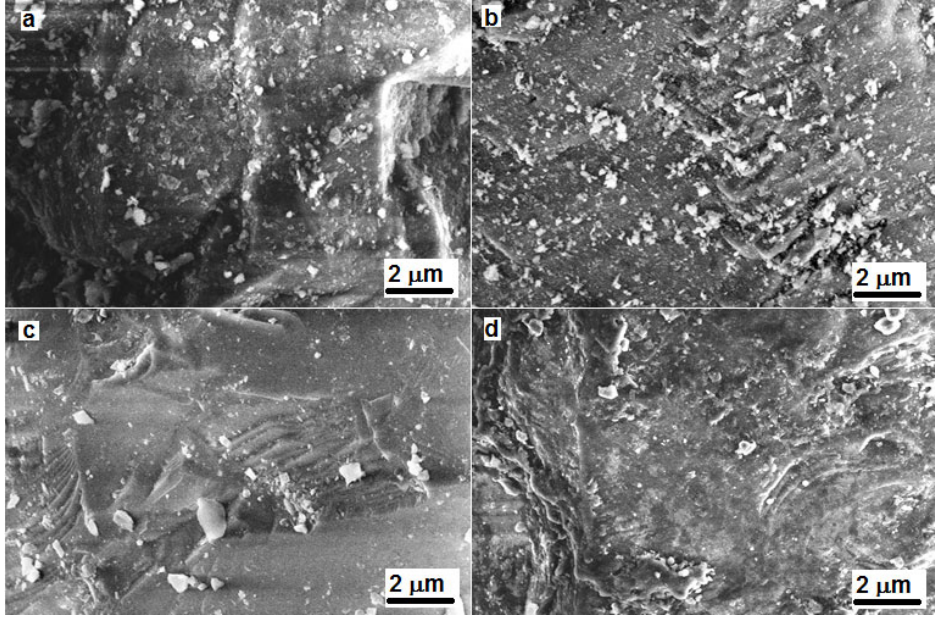
Figure 7. SEM images of ( a ) fine silica sand, ( b ) coarse silica sand, ( c ) river sand and ( d ) M sand.